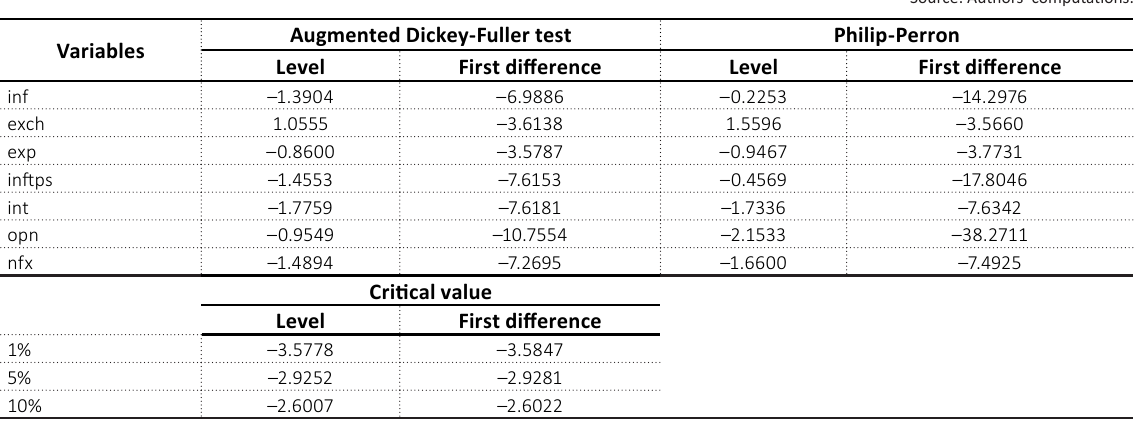
Table 4. Unit root test